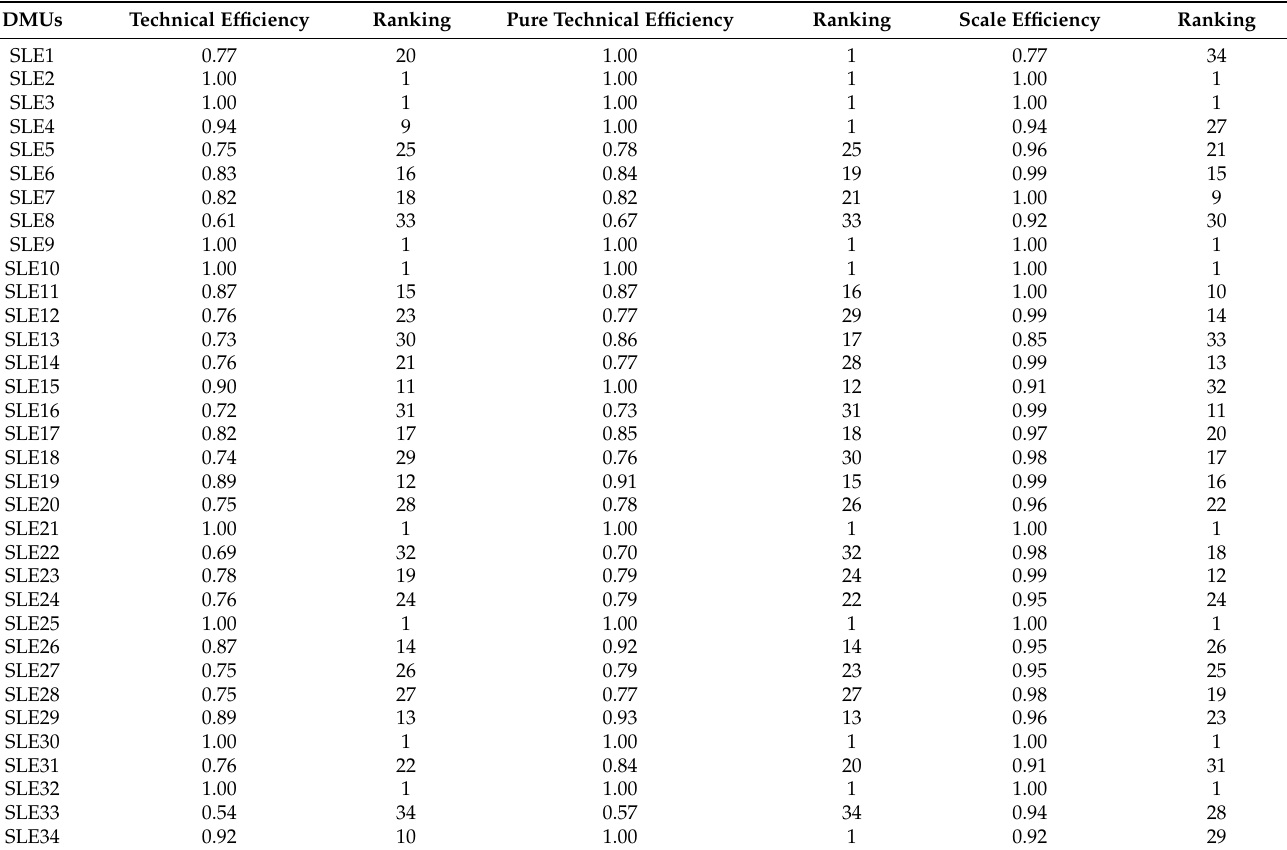
Table A4. Technical efficiency, pure technical efficiency, and scale efficiency for 34 listed LED energy enterprises in